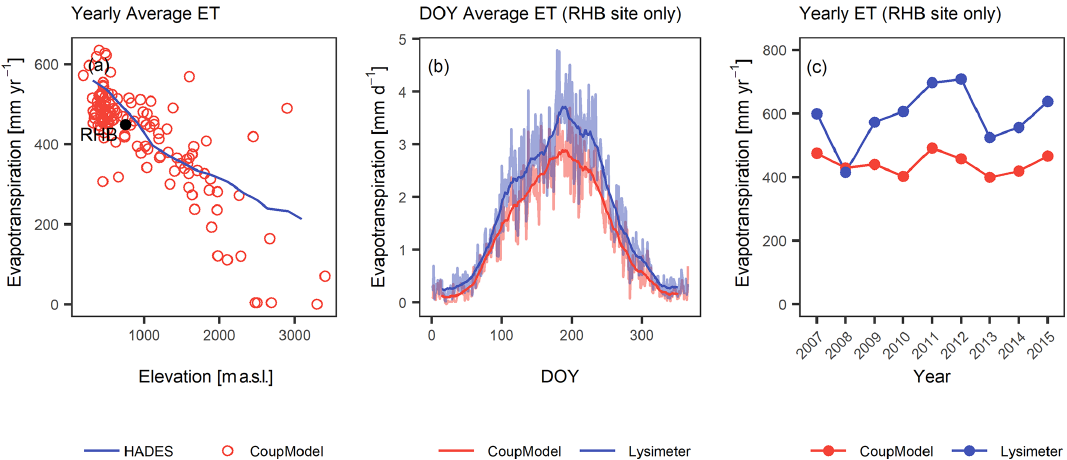
Figure 10. Simulated evapotranspiration (ET) from the CoupModel versus validation data. (a) Yearly average ET versus elevation function from the Swiss Hydrological Atlas, (b) day of the year’s average ET and (c) yearly ET at the Rietholzbach site (RHB) vs. lysimeter data measured at this